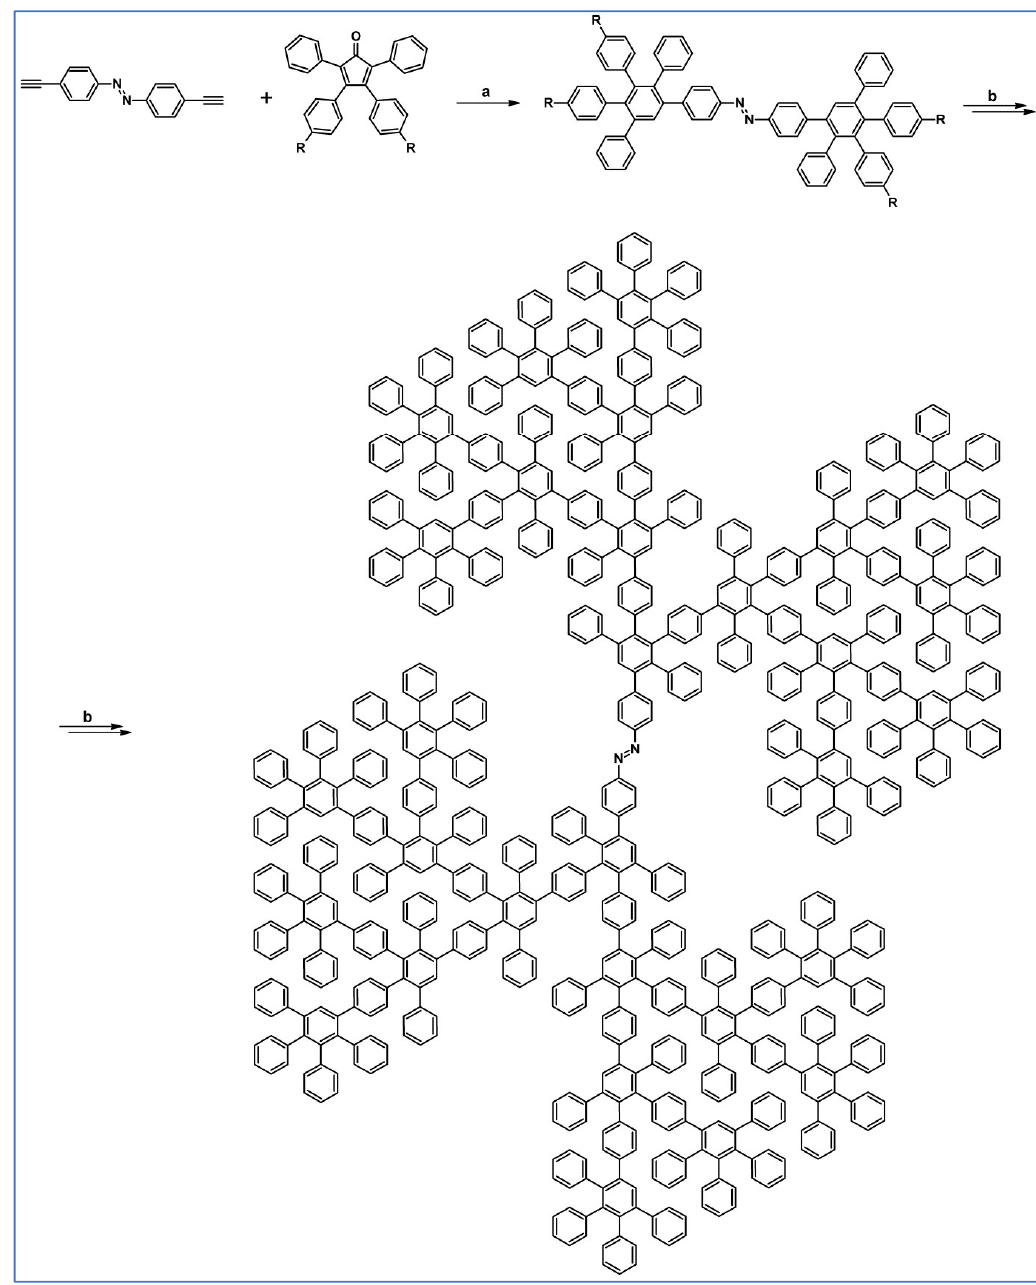
Scheme 164. DA cycloaddition with CO extrusion as a crucial tool for the preparation of polyphe- nylene denrimers posessing azobenzene core [218]. Reagents and conditions: a = o -xylene, 142